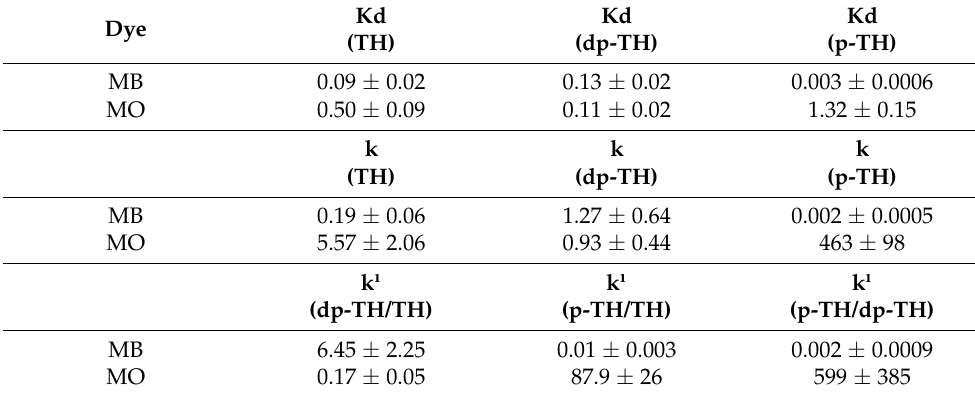
Table 2. Distribution, selectivity, and relative selectivity coefficients of TH, dp-TH, and p-TH COFs for the absorption of both MO and MB